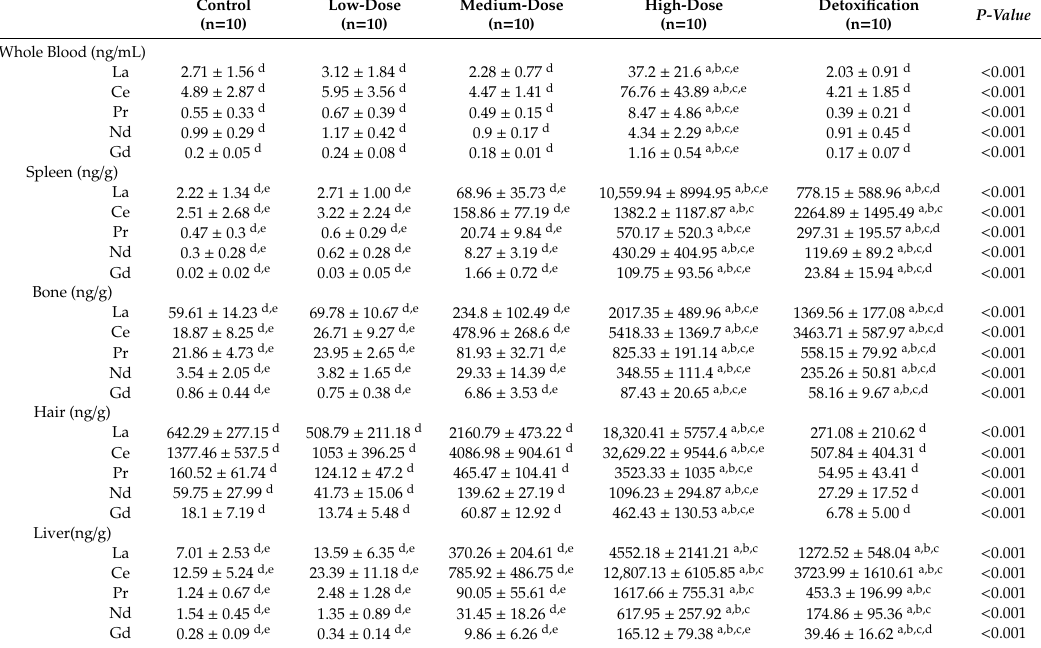
Table 1. The absolute concentration of the five REEs in the di ff erent tissues and organs from rats in the di ff erent